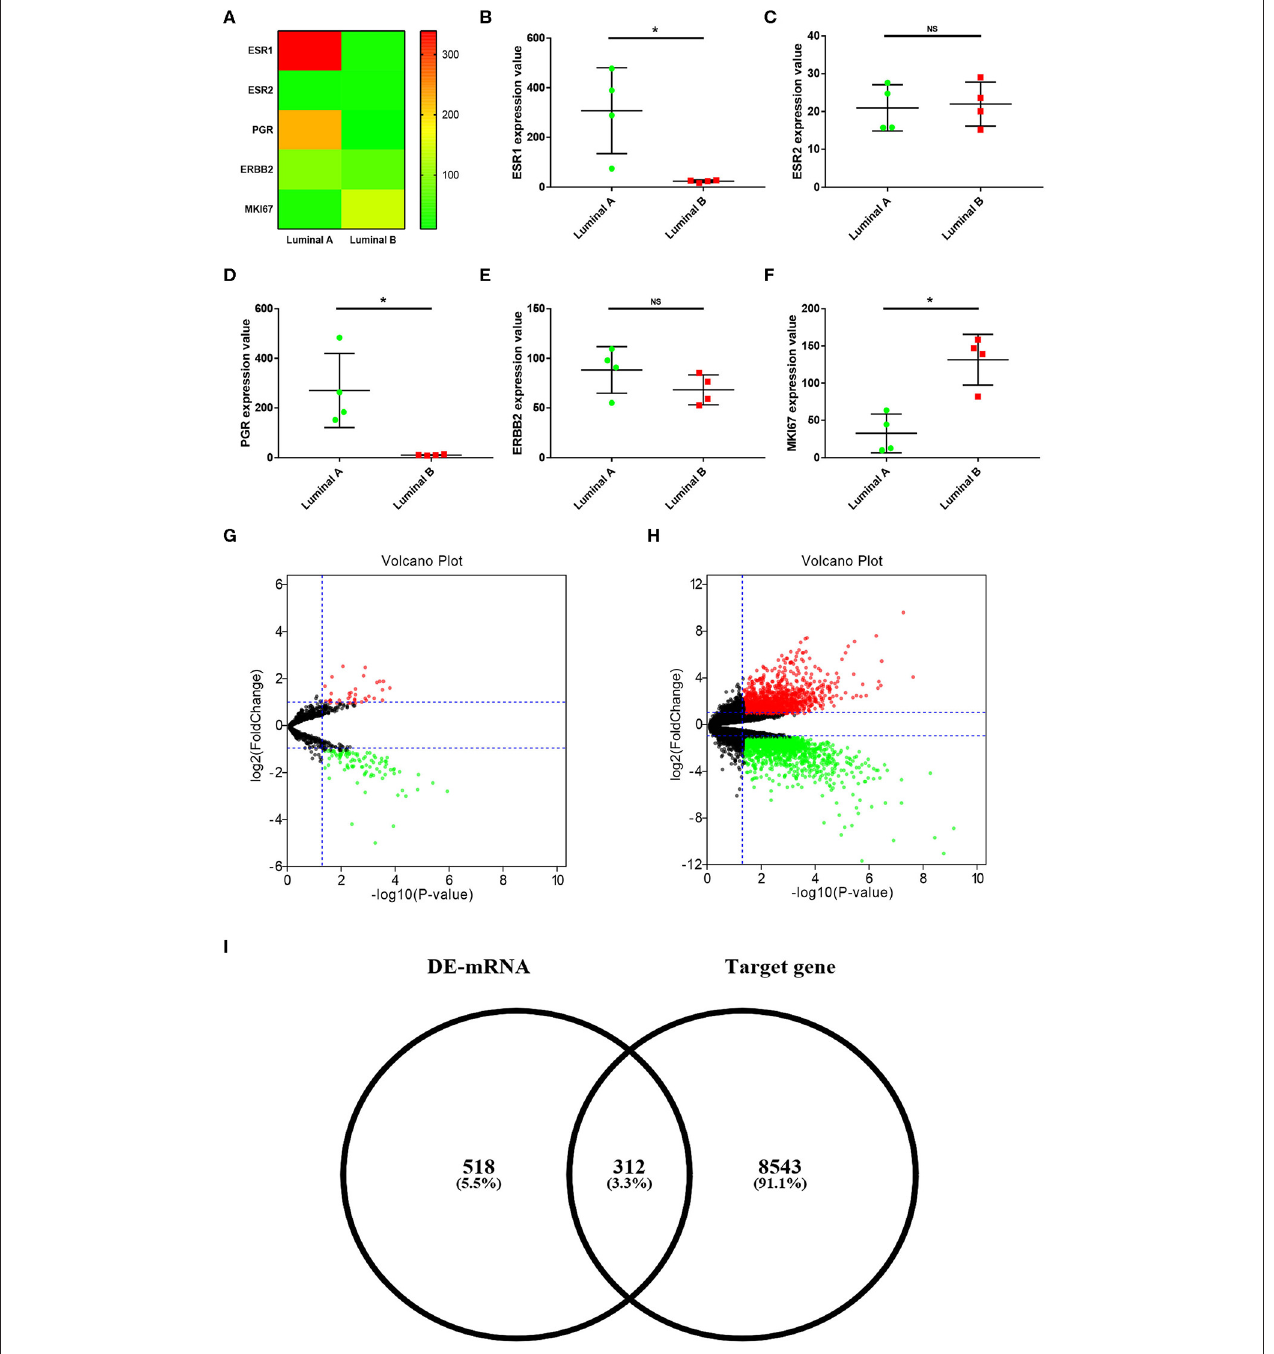
FIGURE 1 | Identification of significant DE-miRNAs and candidate DE-mRNAs between luminal A and luminal B breast cancer. (A) The expression heatmap of several key genes (ESR1, ESR2, PGR, ERBB2, and MKI67) in ER α positive breast cancer. (B) ESR1 expression levels in luminal A and luminal B breast cancer. (C) ESR2 expression levels in luminal A and luminal B breast cancer. (D) PGR expression levels in luminal A and luminal B breast cancer. (E) ERBB2 expression levels in luminal A and luminal B breast cancer. (F) MKI67 expression levels in luminal A and luminal B breast cancer. The data were shown as mean ± standard deviations. “*” represented significant difference, with P < 0.05. (G) DE-miRNAs between luminal A and luminal B breast cancer. (H) DE-mRNAs between luminal A and luminal B breast cancer. | log 2 FC | > 1 and adjust P < 0.05 were set as the thresholds for identifying DE-miRNAs and DE-mRNAs. Red dots and green dots represented upregulated and downregulated DE-miRNAs (DE-mRNAs) in luminal B breast cancer compared with luminal A breast cancer, respectively. Black dots represented DE-miRNAs (DE-mRNAs) that were not differentially expressed between luminal A and luminal B breast cancer. (I) Identification of candidate genes by intersection of DE-mRNAs and potential target genes of DE-miRNAs.